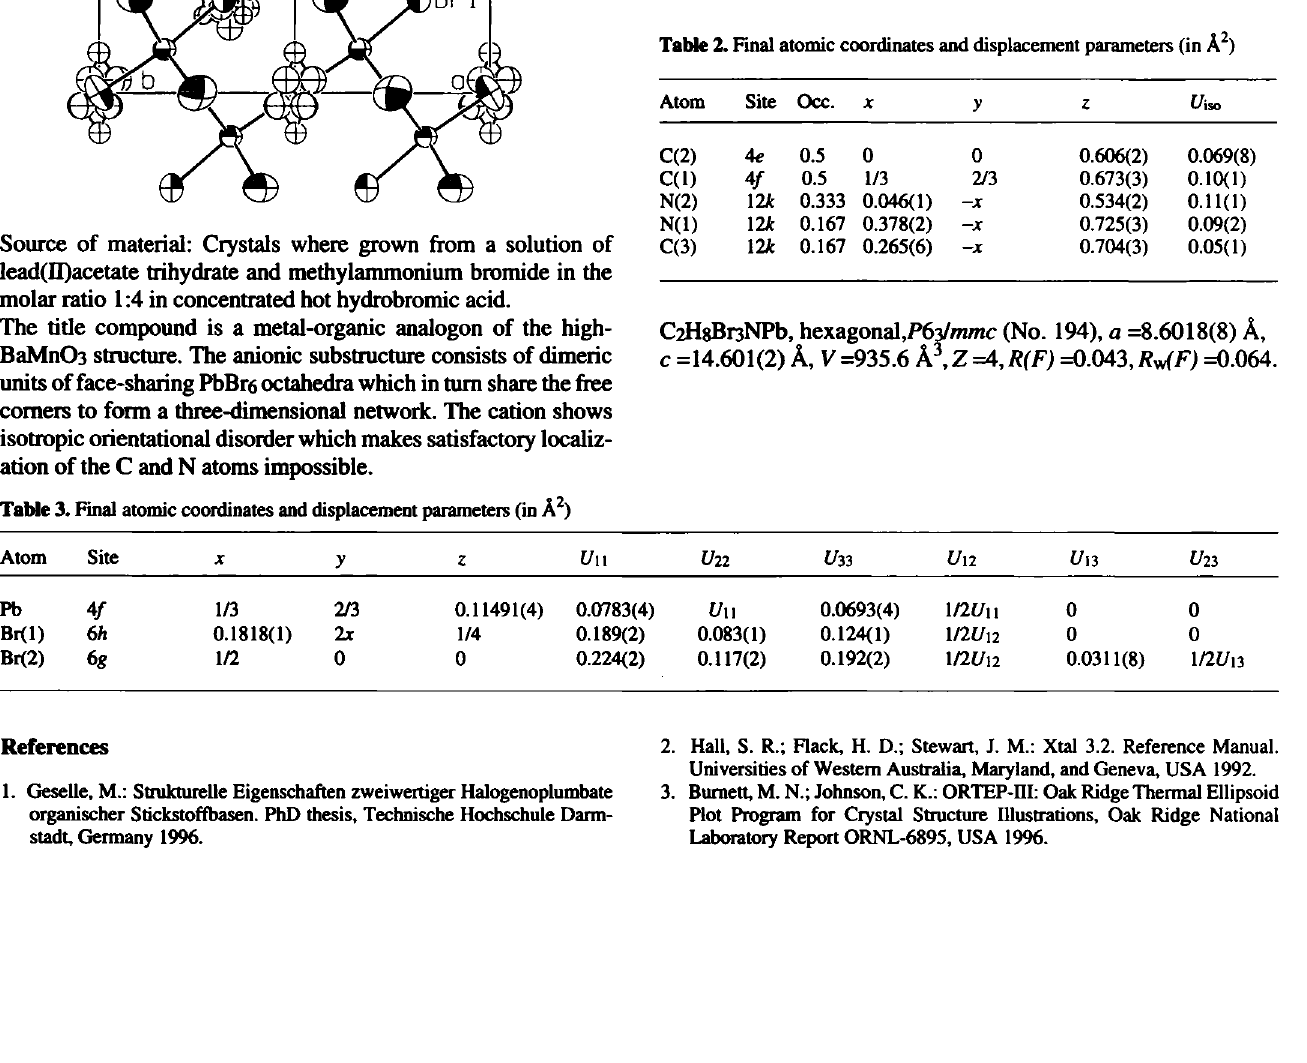
Table 1. Parameters used for the X-ray data collection Crystal: